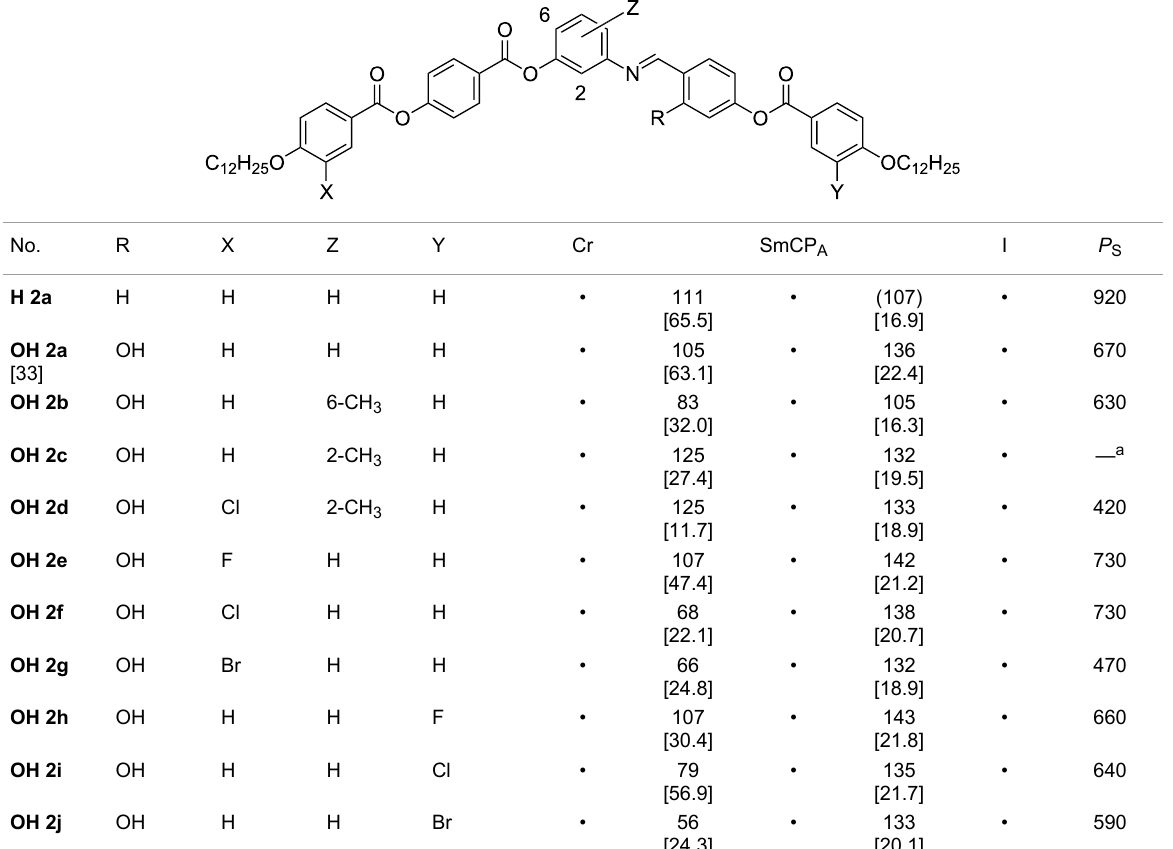
tion was calculated from the area under the repolarization peaks to be 660 nC/cm 2 . The switching behaviour of OH 2a is representative for all compounds OH 2a–j . The P S values are given in Table